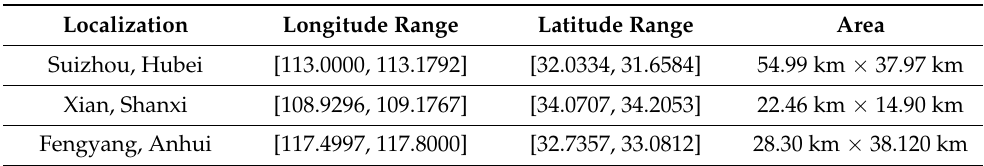
Table 2. Details of reference road map for each area. The longitude and latitude are measured under WGS 84.